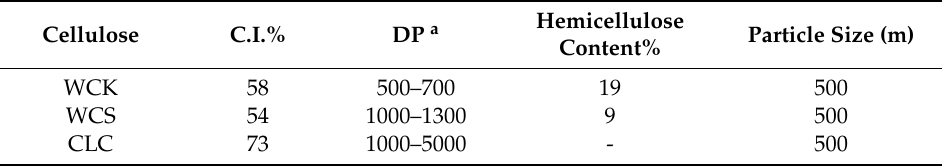
Table 1. Main parameters of the studied